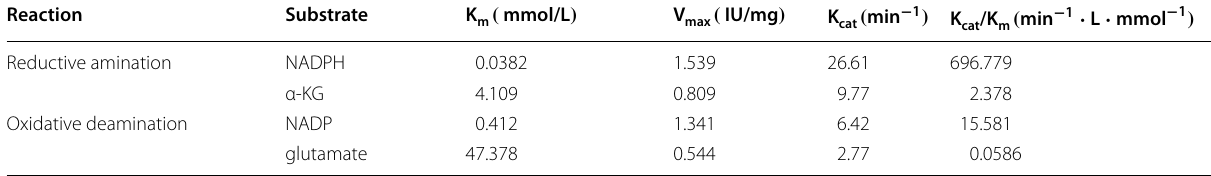
Table 3 Kinetic parameters of GdhB for reductive amination and oxidative deamination reaction Reaction Reductive